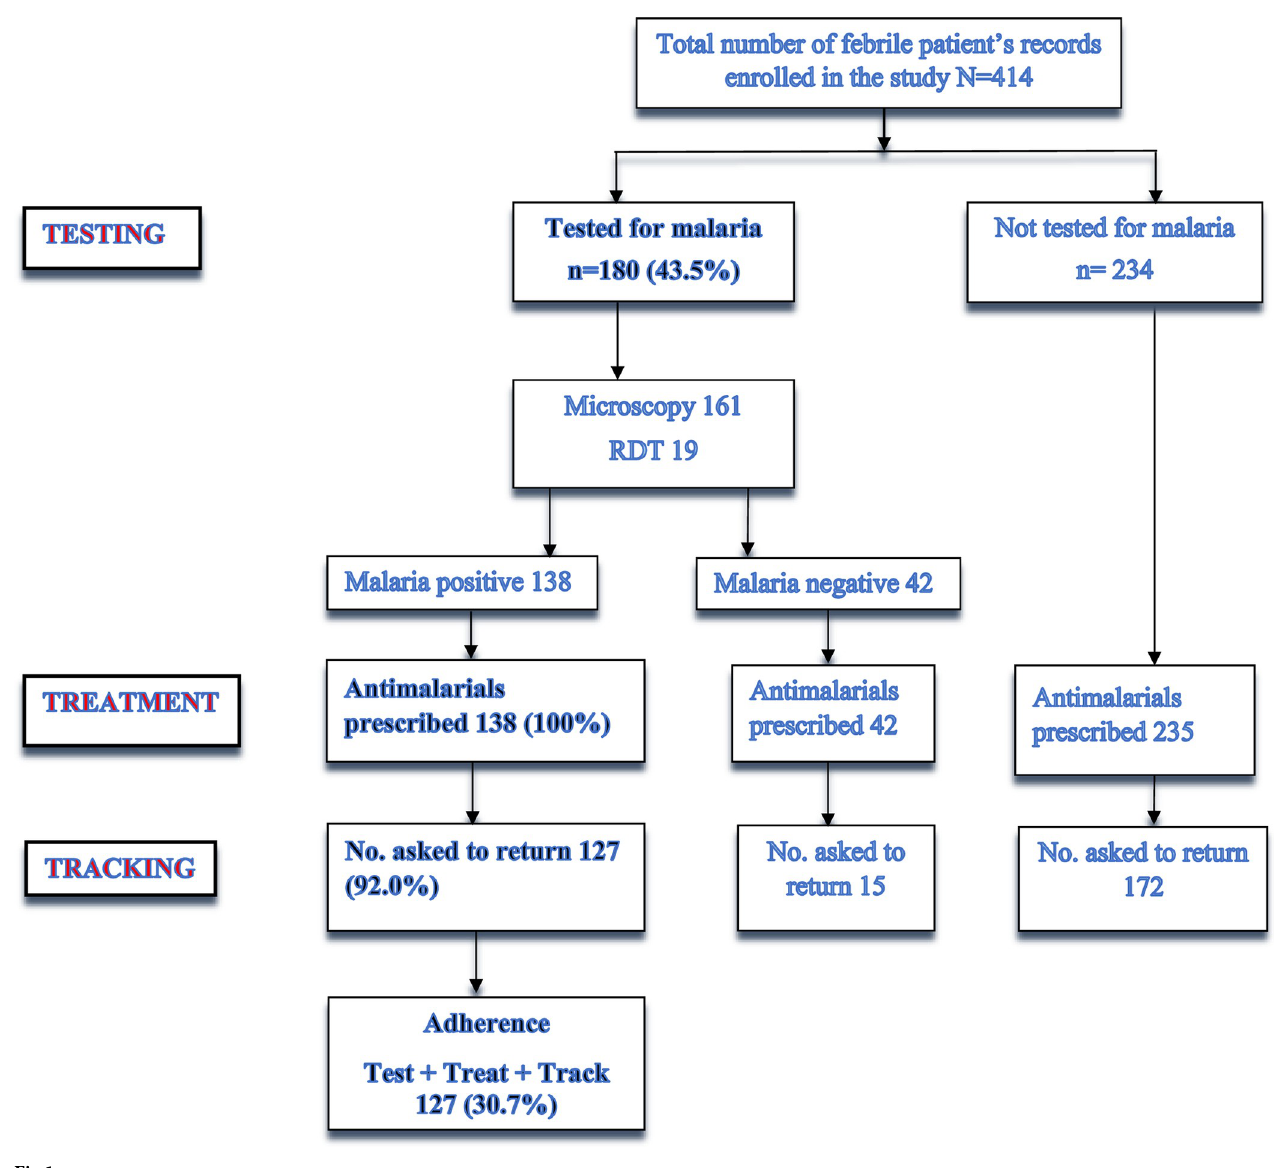
Fig 1. included patient age, number of qualified laboratory scientists in a facility, NMCP monitoring, prescriber age and sex, professional category, number of years in service and training. It was observed that less than half of suspected malaria case patients were either tested by microscopy or RDT. Studies in other countries have reported varying percentages of testing of suspected malaria cases. Compared to the findings from this study, higher testing of suspected malaria cases were reported in other studies across the continent which ranged from 64.6% to 85.2% [6, 13, 23–25]. In Ogun State Nigeria, 85.2% testing rate was established in public facili- ties while 32.9% testing was done in private facilities [26]. On the other hand, lower testing of suspected malaria cases have been reported in other studies in sub-Saharan Africa, Malawi 34.0% [27]. Similar findings to the testing rate in our study, are studies in Sudan 43.5% [11],